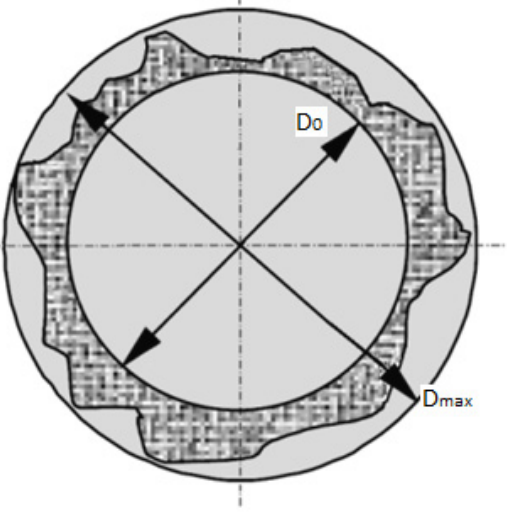
Figure 6. Measurement of the maximum delaminated and hole